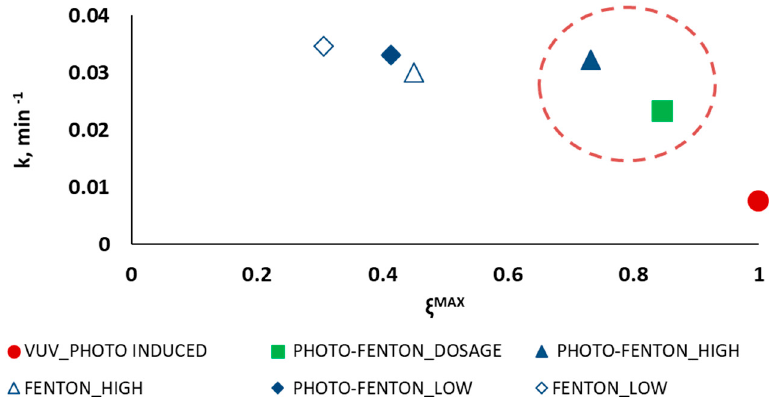
Figure 3. Reaction rate as a function of the maximum attainable conversion evaluated for photo induced advanced oxidation process ( ● ); Fenton ( ◊ ) and photo-Fenton ( ♦ ) process without H 2 O 2 dosage using low concentrations of the Fenton reagents; Fenton ( ∆ ) and photo-Fenton ( ▲ ) process without H 2 O 2 dosage using high concentrations of the Fenton reagents; and photo-Fenton process following a H 2 O 2 dosage strategy ( ■ ).